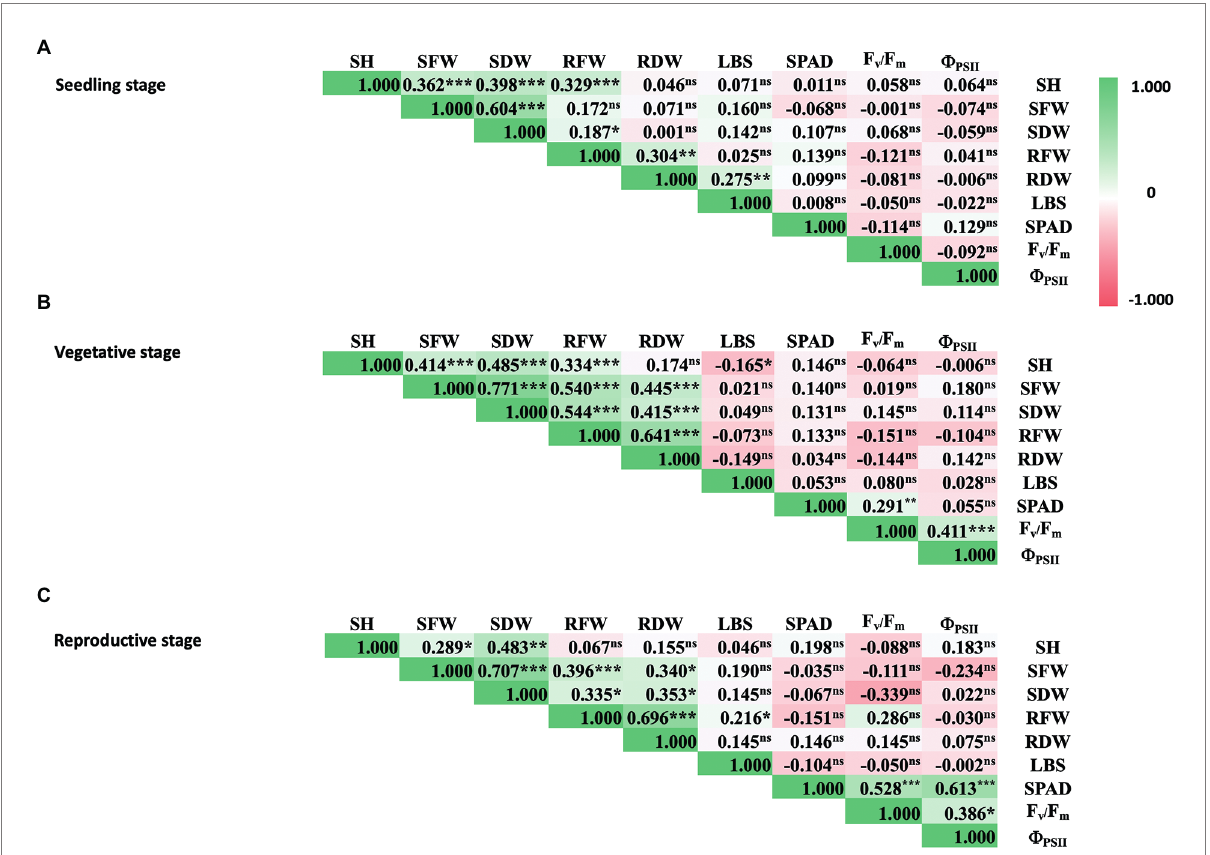
FIGURE 2 Correlation matrix of physiological and agro-morphological traits of rice at seedling (A) , vegetative (B) , and reproductive stages (C) under 100 mM FeSO 4 conditions. Colored bars represent correlation values from − 1.0 (red) to 1.0 (green). SH, shoot height; SFW, shoot fresh weight; SDW, shoot dry weight; RFW, root fresh weight; RDW, root dry weight; LBS, leaf bronzing symptom; SPAD, leaf greenness index; F v /F m , maximum quantum yield of PSII; Φ PSII , photon yield of PSII. Pearson correlation coefficients are indicated in the boxes and p -values are indicated as 0.001 (***), 0.01 (**), 0.05 (*), or not significant ( ns